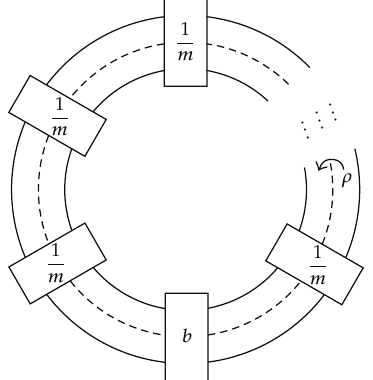
Figure 3: The strongly invertible links L (cid:4)(cid:4) (cid:3) m,d (cid:4) and its involution.